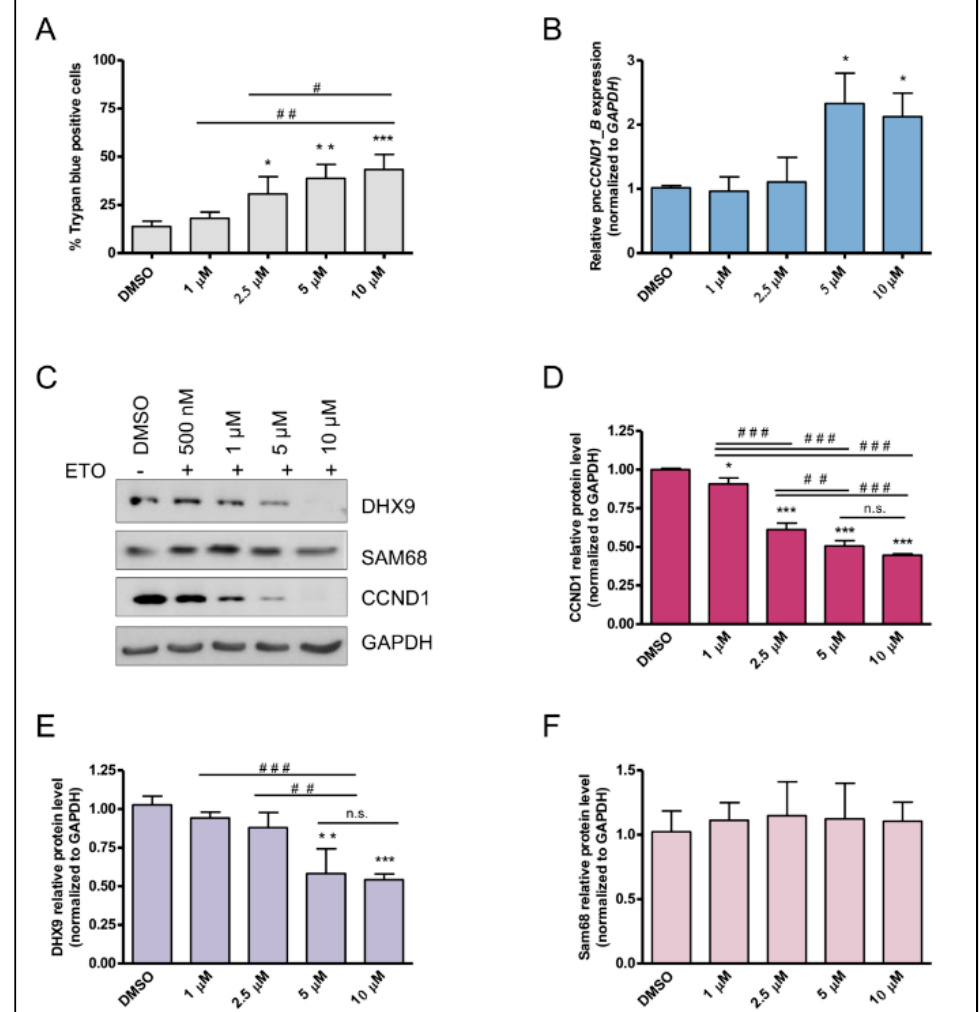
Figure 2. Etoposide treatment inversely affects pncCCND1_B and CCND1 in a dose dependent fashion. ( A ) Percentage of blue positive cells by Trypan blue staining at 16 h after treatment with different concentrations of Etoposide. ( B ) RT-qPCR analysis of pncCCND1_B expression at different etoposide concentrations, as in A. ( C ) Western blot analysis upon treatment with either DMSO (vehicle) or increasing concentration of etoposide (ETO). After 16 h of treatment, DHX9, Sam68, and CCND1 protein levels were analyzed in protein total lysates (15 µg). GAPDH was used as the loading control. Histograms represent CCND1 ( D ), DHX9 ( E ), and Sam68 ( F ) protein levels normalized to the GAPDH signal and relative to DMSO. Statistical analysis was performed by ANOVA with Bonferroni correction. p -value (*, # < 0.05, **, ## < 0.01, ***, ### < 0.005, n.s. >